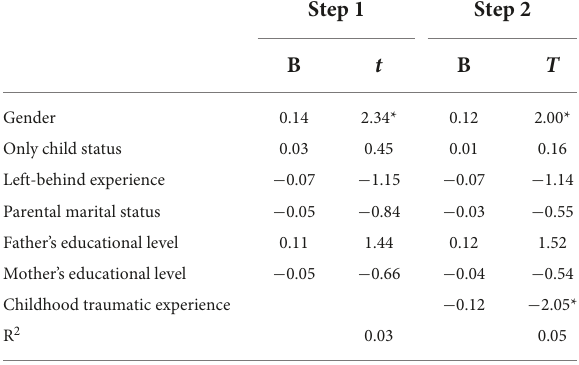
TABLE 3 Regression of post-traumatic growth to traumatic experiences in